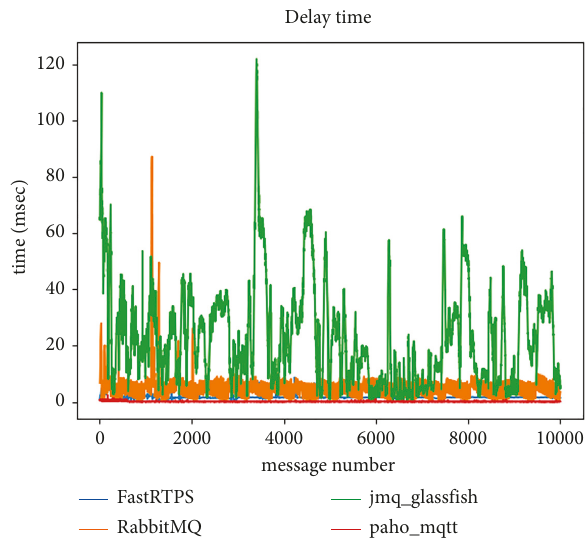
Figure 20: The delay time in the case of a limited